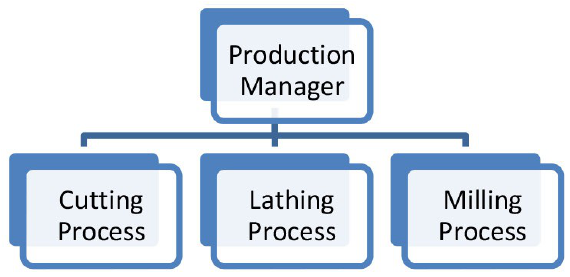
Figure 5. Process based organizational